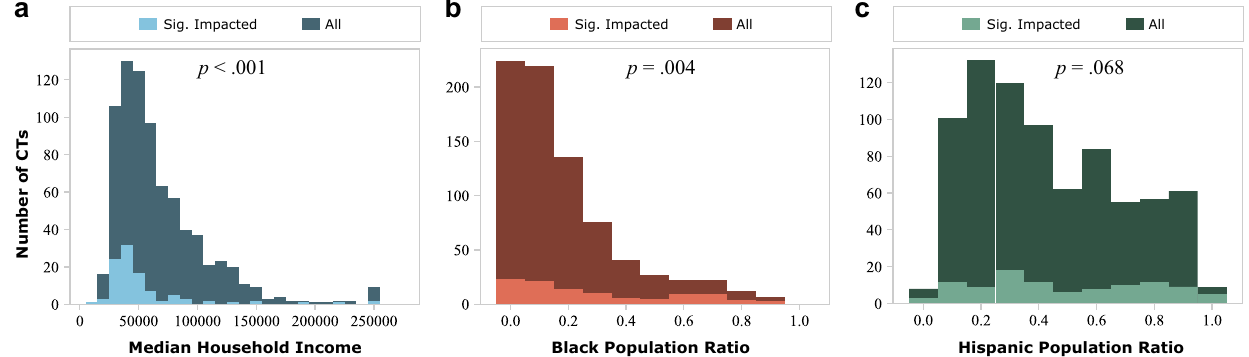
Fig. 5 Comparison between all census tracts (CTs) and signi fi cantly impacted census tracts due to power outages in Harris County from the aspects of income, race, and ethnicity. The aspects of income, race, and ethnicity are represented by a median household income, b Black population ratio, and c Hispanic population ratio.